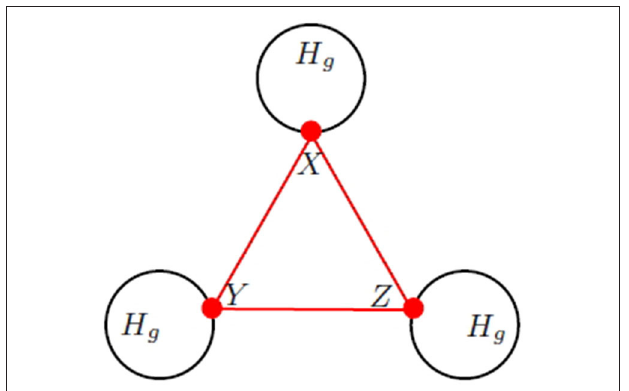
FIGURE 8 | Koch network G m , g .